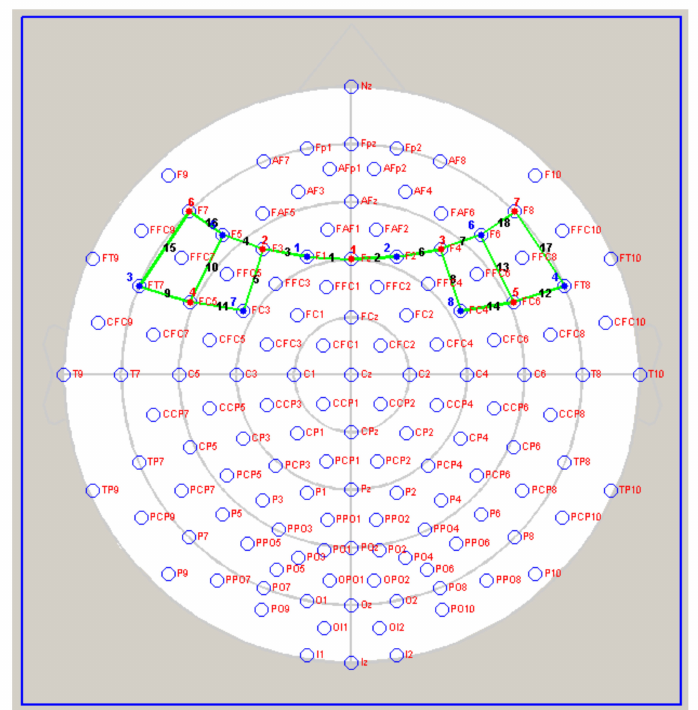
Figure 2. 2D representation of the 18-channels array of optodes (7 light sources / emitters and 8 detectors). The emitters are represented by bold red numbers, whereas bold blue numbers represent the detectors. Green lines symbolize the channels created between emitters and optodes. Each channel has its number (i.e., black bold numbers) from 1 to